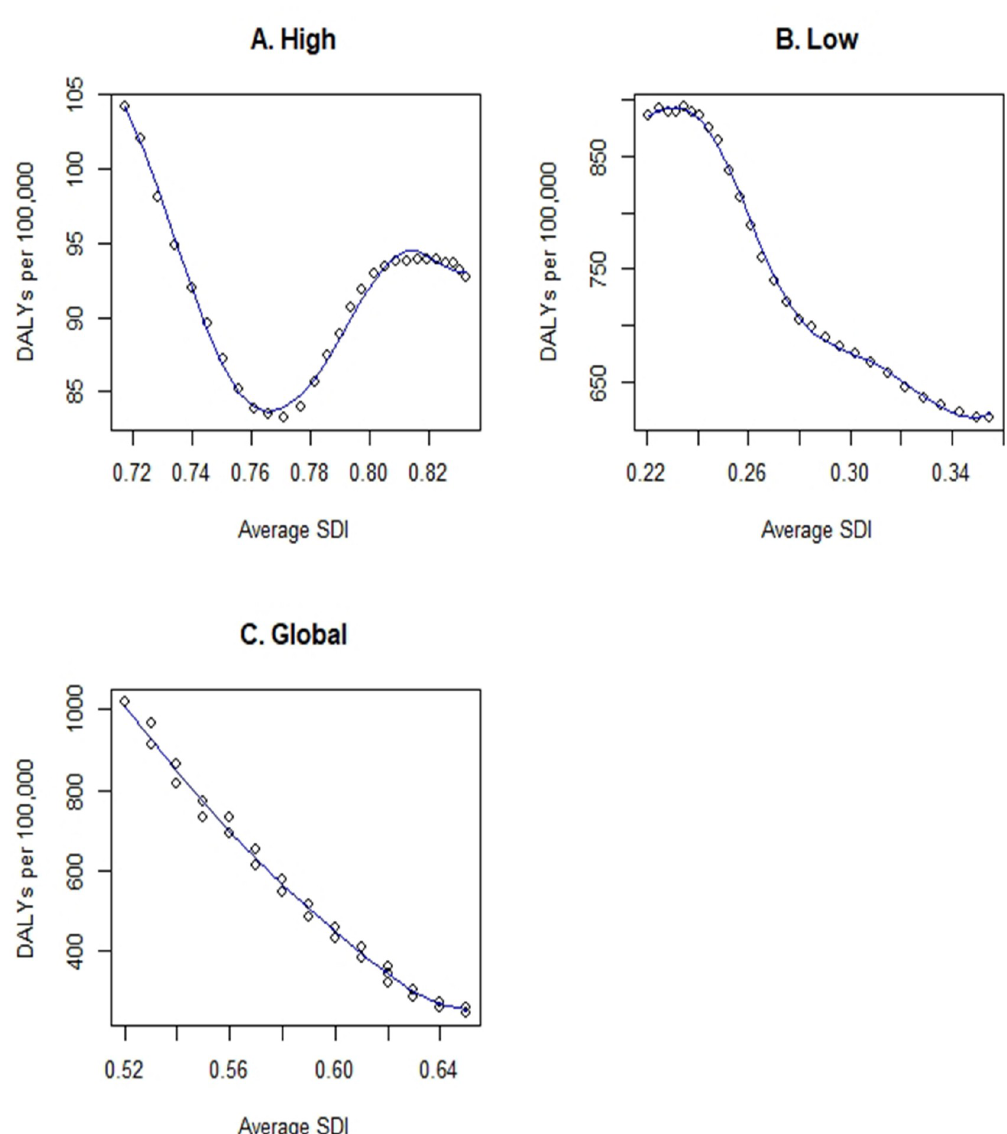
Fig 4. The relationship between DD DALYs and sociodemographic index (SDI) for WB high-income (A), WB low-income (B) and global data combined (C). Each data point represents a single year from 1990–2017 and represents totaled DD DALYs per 100,000 for all WB high-income countries (A), WB low-income countries (B), or globally (C). The volatility statistic had a value of 13,254.65 for WB high-income regions (95% CI: 7,970.436, 13,837.297), 985,066.7 for WB low-income regions (95% CI: 897,082.9, 1,074,332.5), and 4,754,435.2 globally (95% CI: 3,415,048.0,